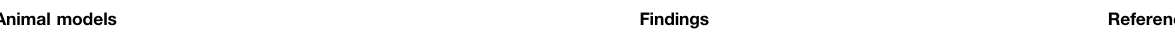
TABLE 1 | Altered gut microbiota composition in ASD animal models ( ↑ = increased, ↓ =